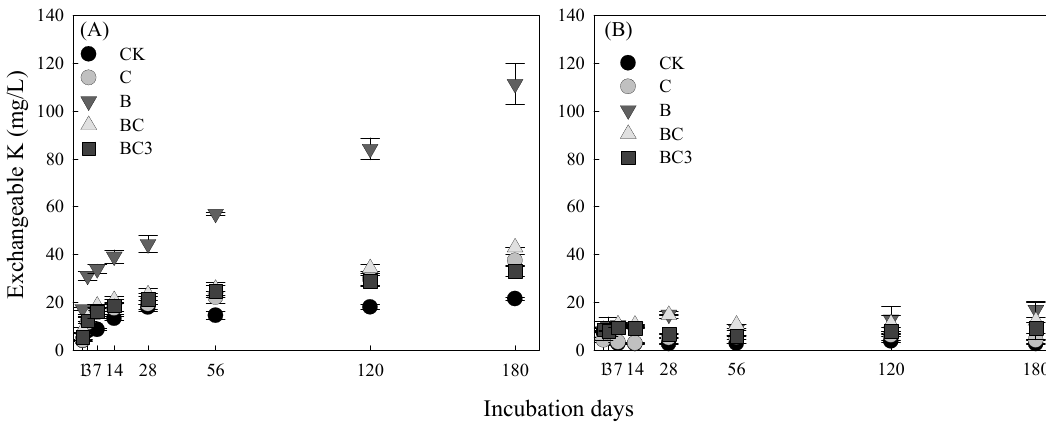
Figure 4. Dynamic changes in the exchangeable K content during the experiment ( A ) sandy soil ( B ) clay soil.